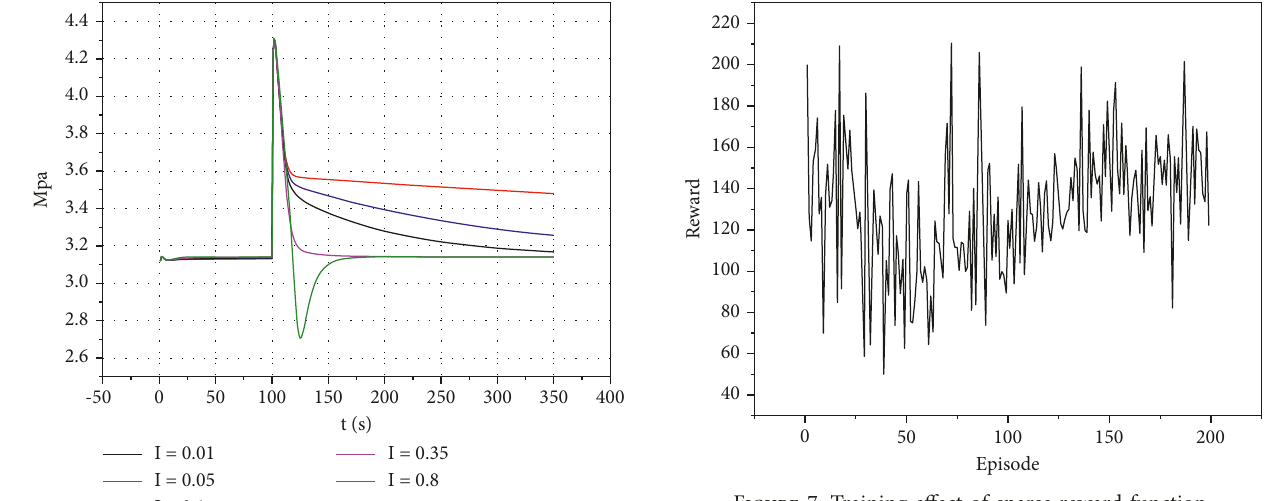
Figure 7: Training effect of sparse reward function.